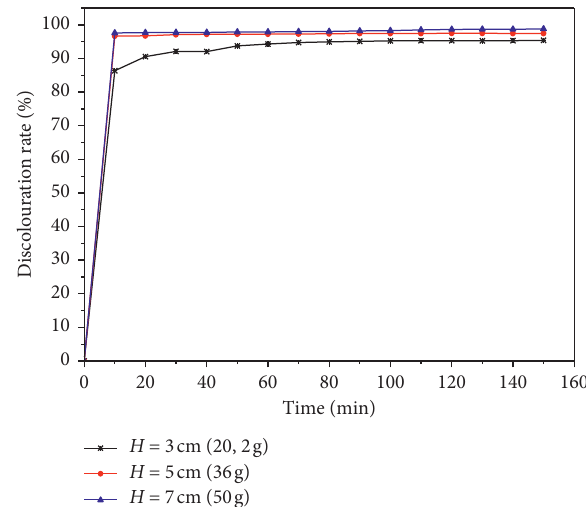
Figure 8: Effect of the sand bed height on the discolouration